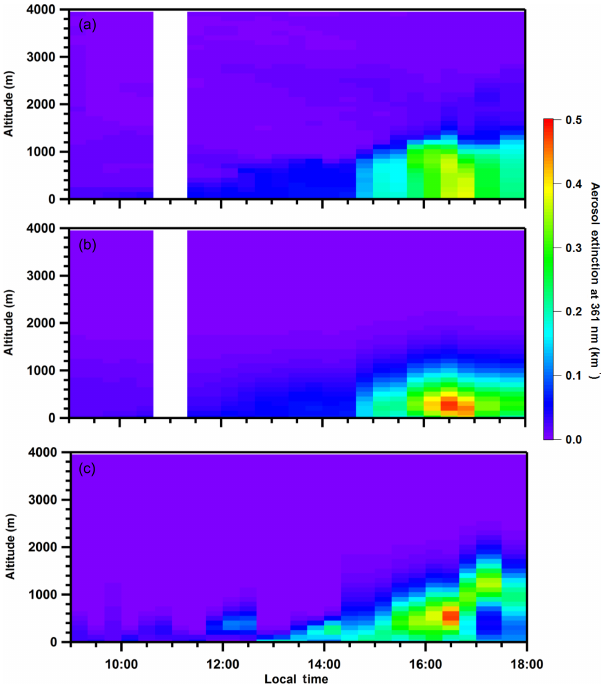
Figure 12. The 23 August vertical profiles of aerosol extinction (361nm) from S ratio of 25sr: averaged lidar (a) , smoothed li- dar (b) , and MAX-DOAS retrieved measurements (c) .